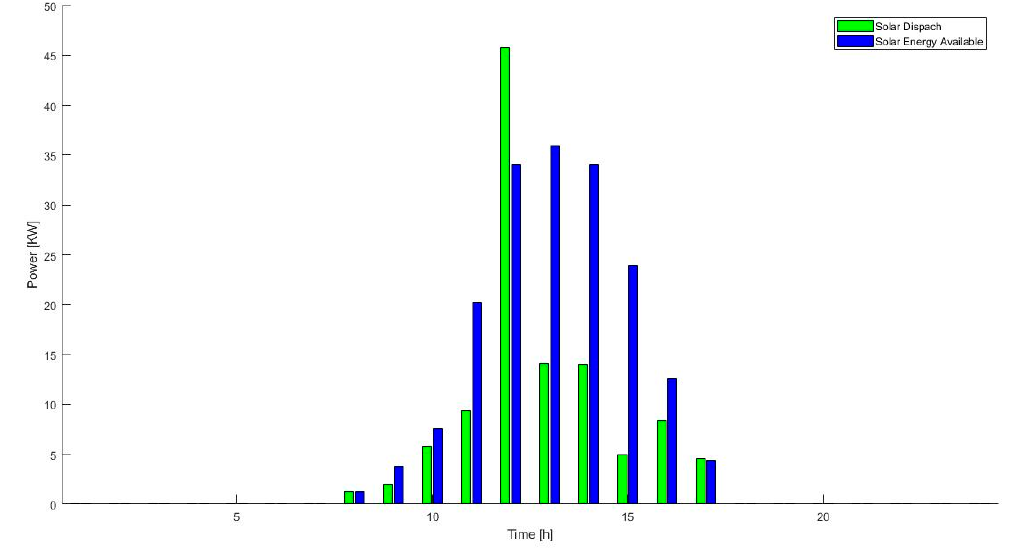
Figure 6. Availability and dispatch of the solar energy system of the MG when the storage system is